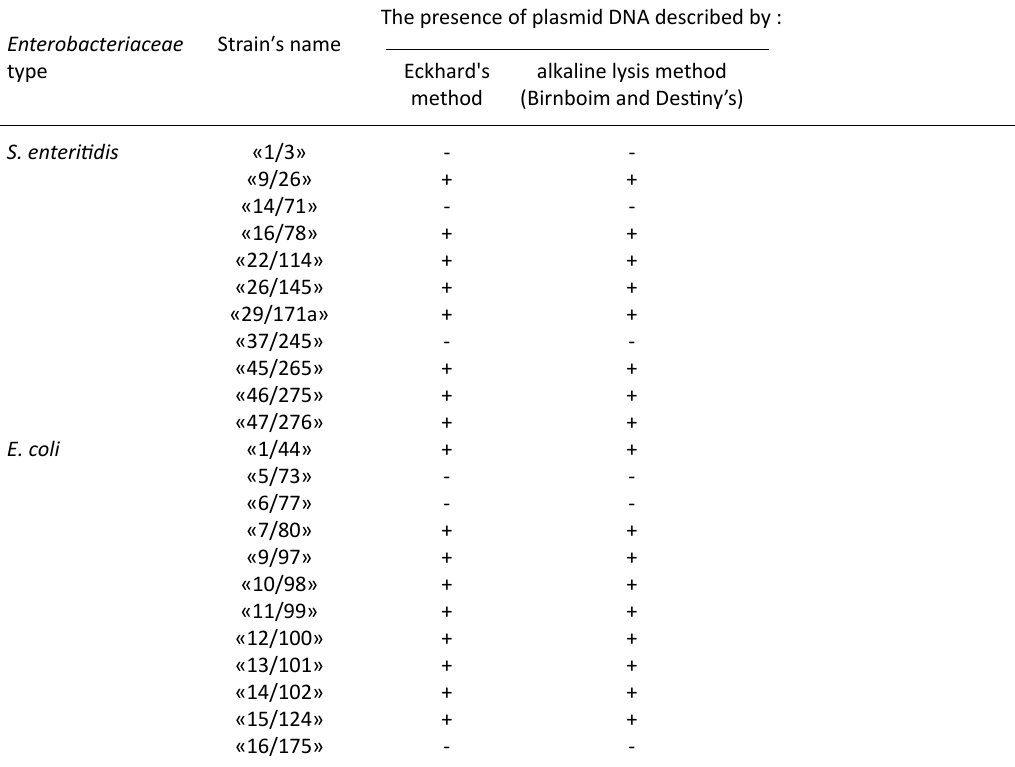
Table 5. Results of plasmid DNA screening in field isolate strains of S. еnteritidis and E. coli The presence of plasmid DNA described by